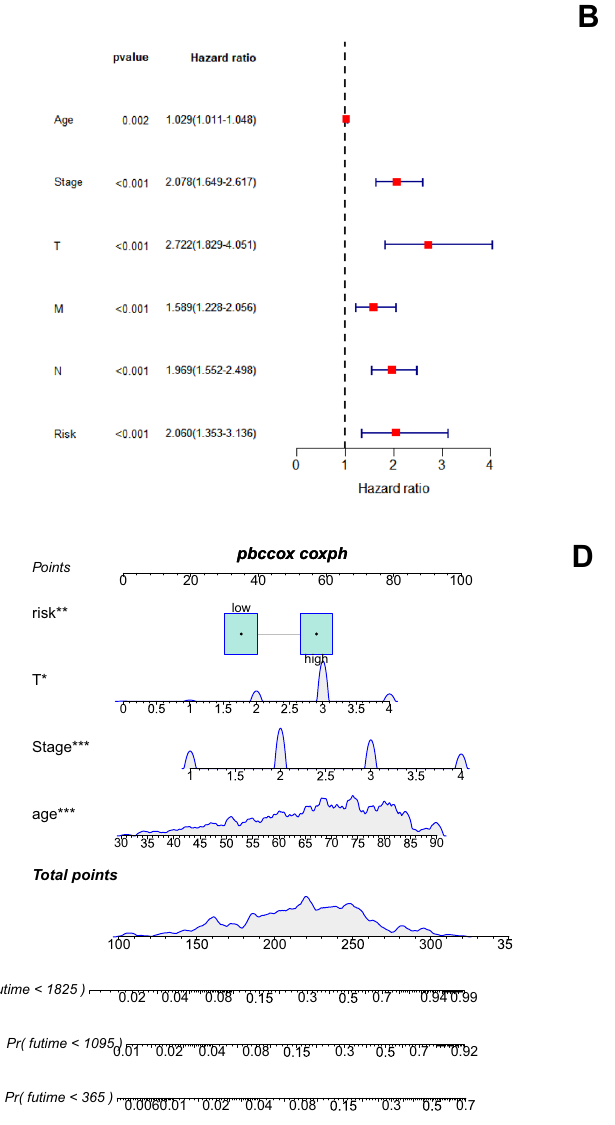
Figure 5. The relationship between clinicopathological factors and prognosis. ( A ) Univariate COX regression analysis forest map. ( B ) Multivariate COX regression analysis forest map. ( C ) A nomogram for predicting the probability of survival at 1, 3 and 5 years. ( D ) Nomogram calibration